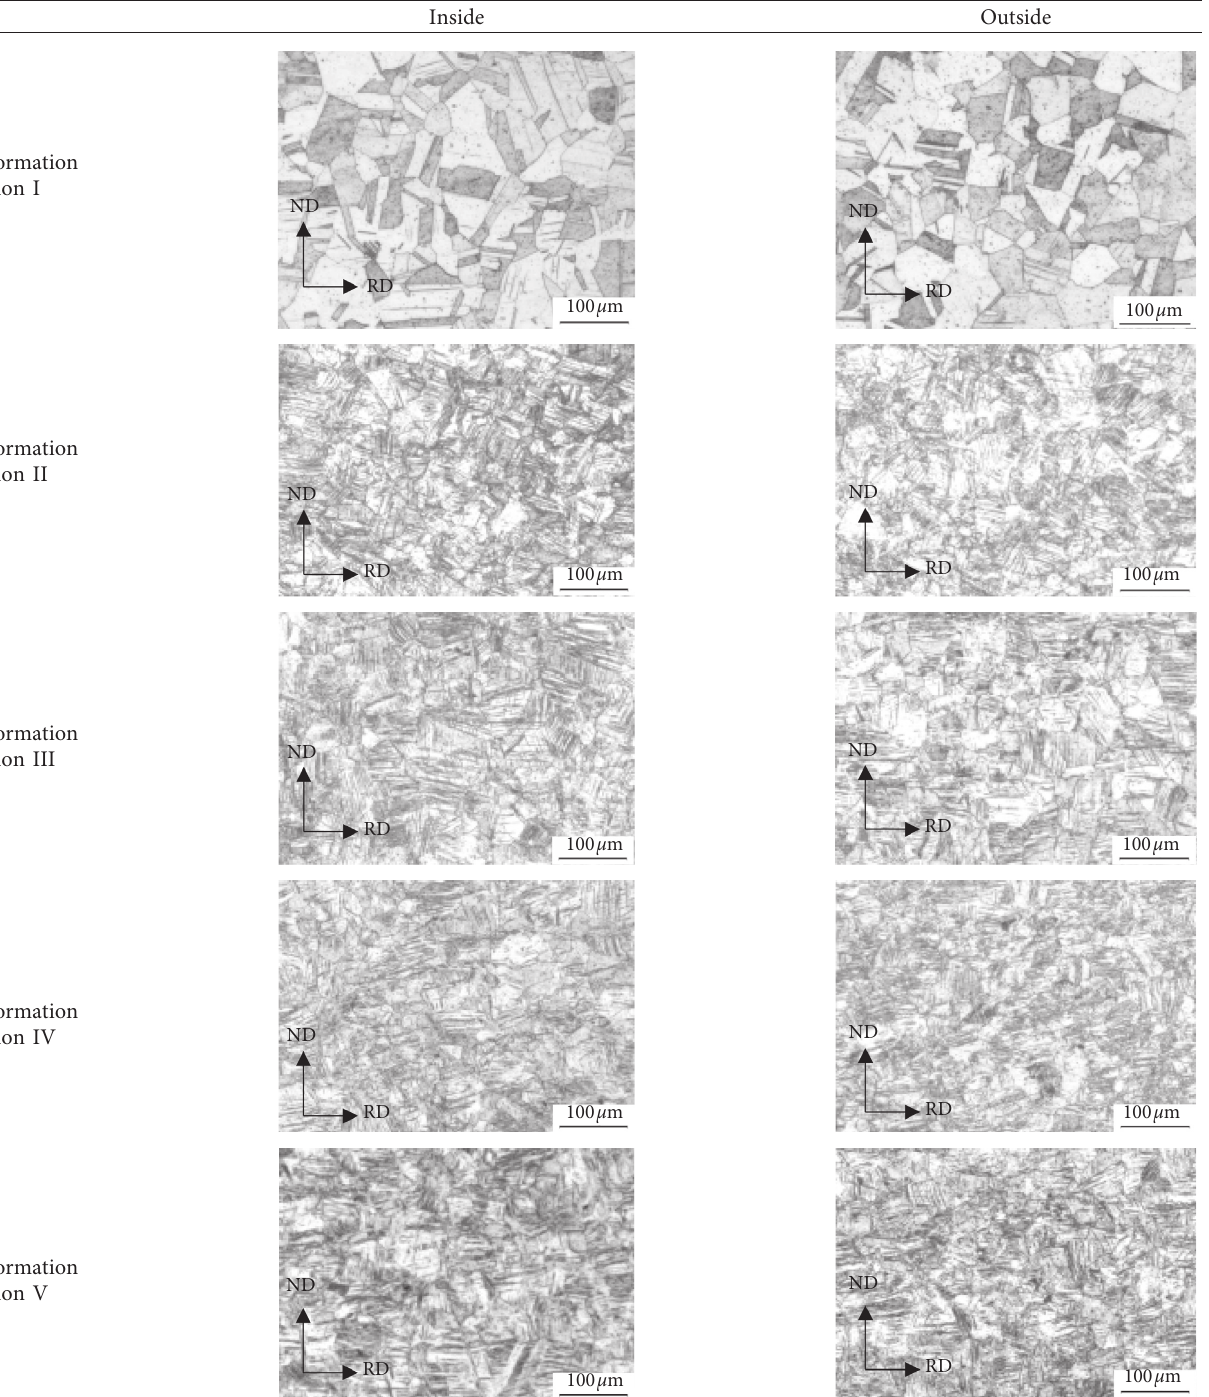
Table 3: Microstructure comparison of the inner and outer wall of the deformed section of the steel tube (observation surface